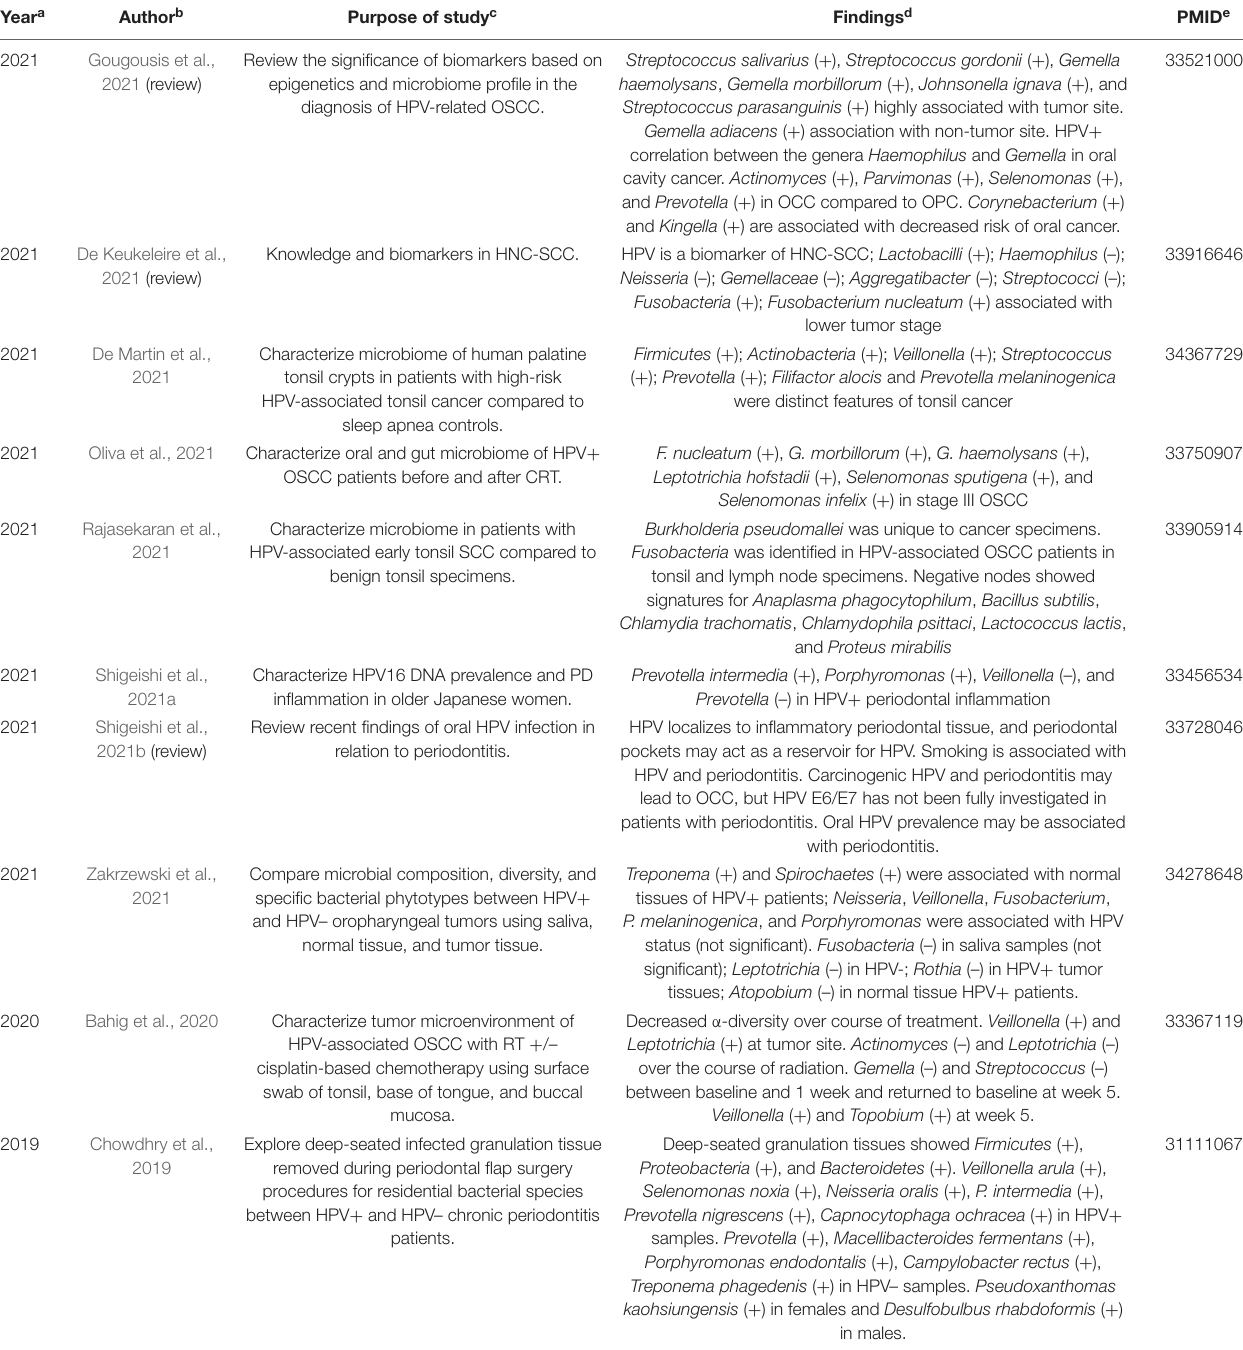
TABLE 3 | LitSuggest positively classified articles ( n = 15) involving HPV and the oral microbiome in HNC